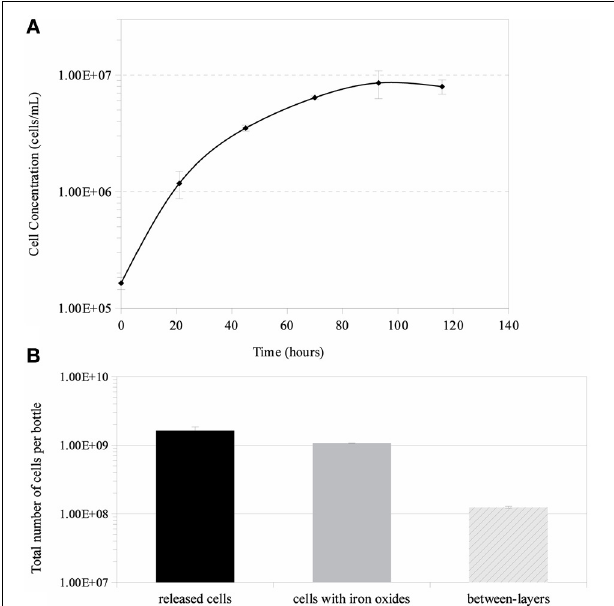
FIGURE 2 | (A) Growth curve of Mariprofundus ferrooxydans , strain PV-1, using a large-batch culture. Error bars indicate standard deviation from the mean ( n = 3). (B) Overall cell yields obtained by using a method to separate cells from their stalks.